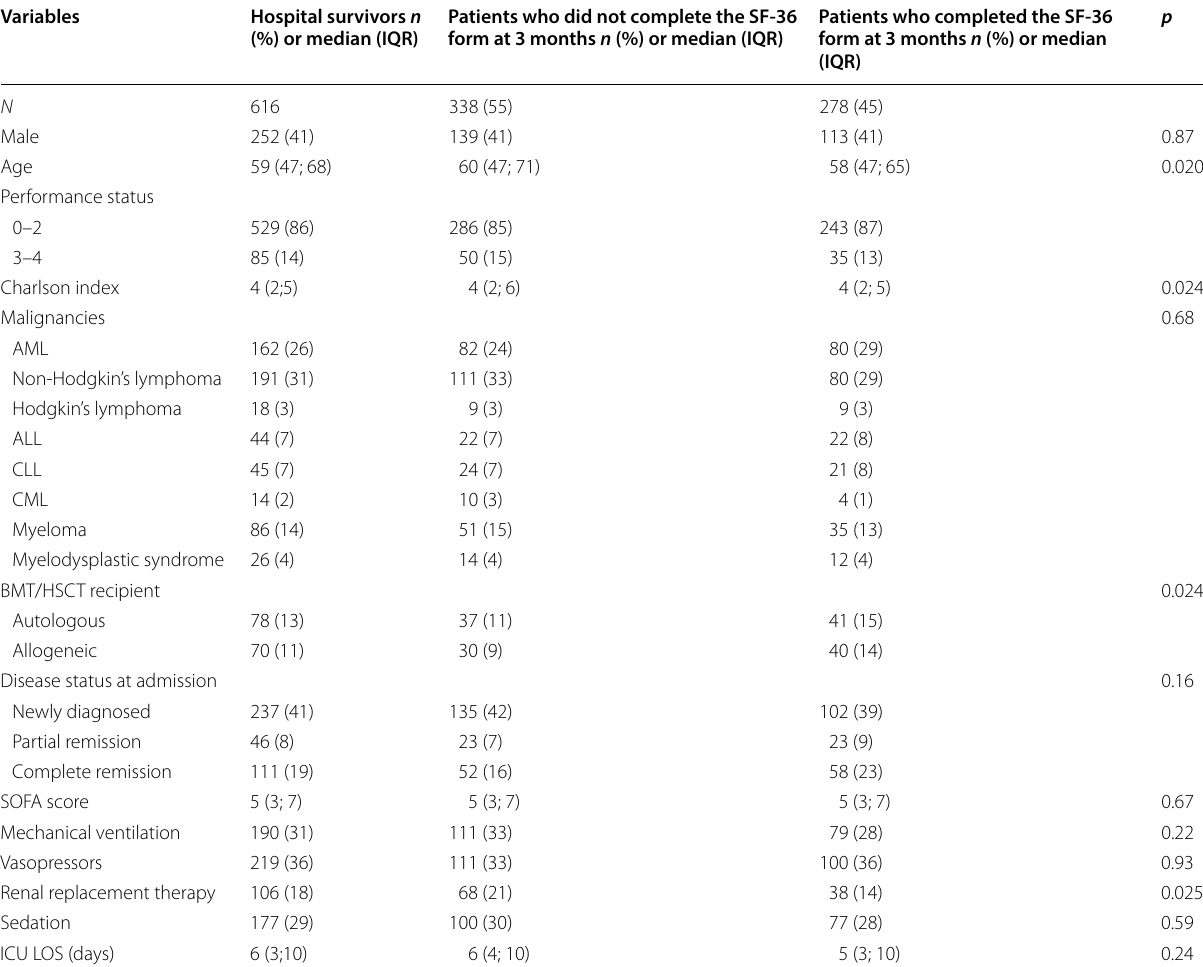
Table 1 Patient characteristics of ICU survivors. Comparison between ICU survivors who completed the SF-36 form and those who did